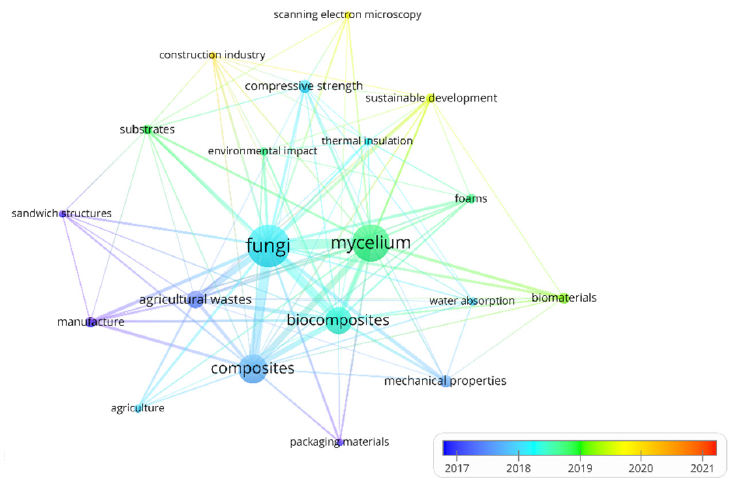
Figure 2. “Author keywords” associations in scientific articles on mycelium-based composites.